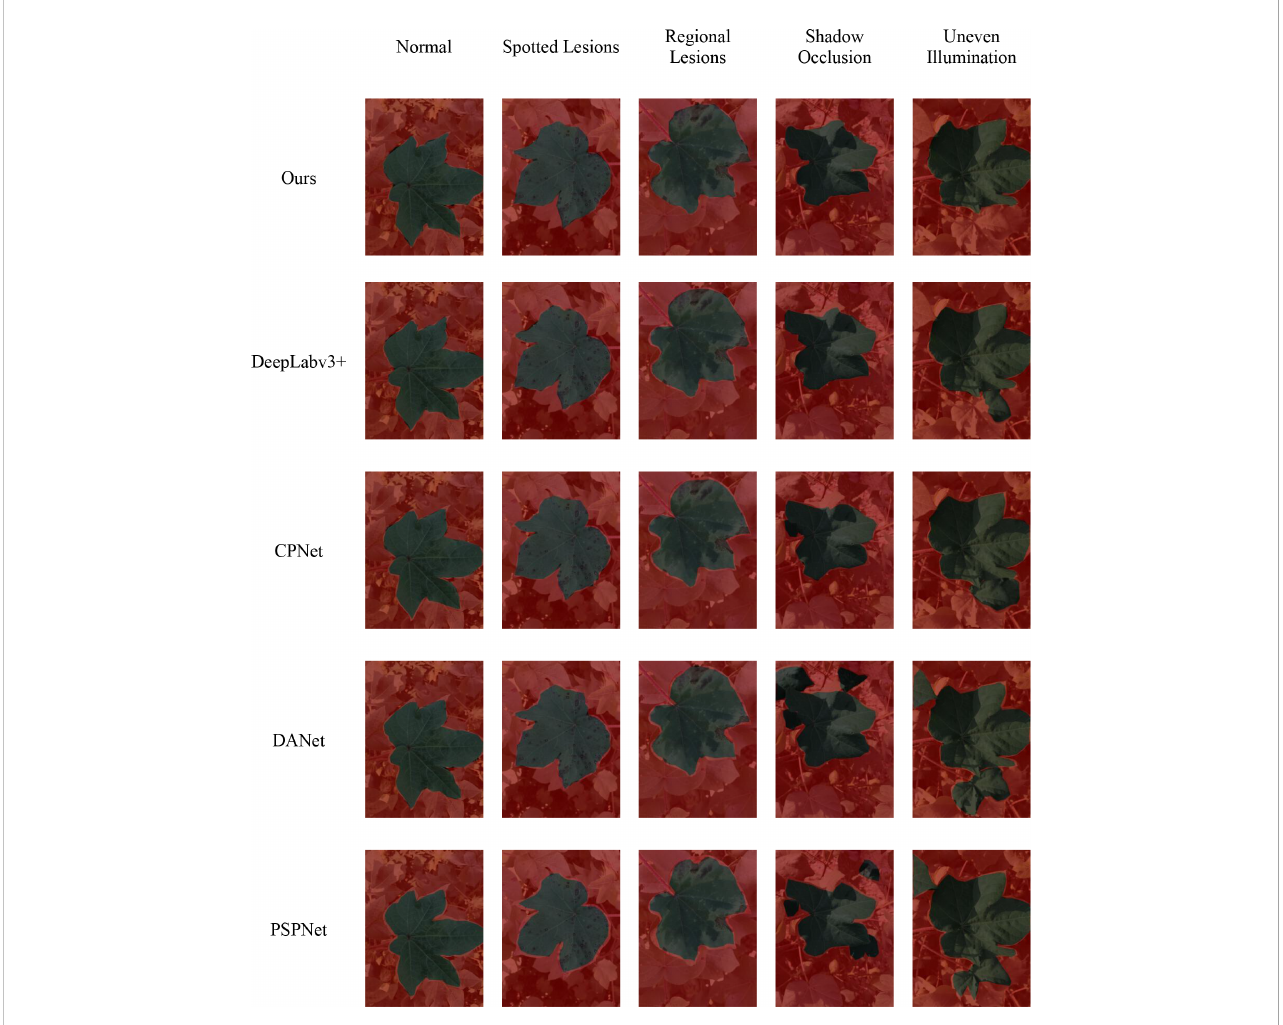
FIGURE 8 Pre-trained segmentation models results on fi ve types of cotton leaf